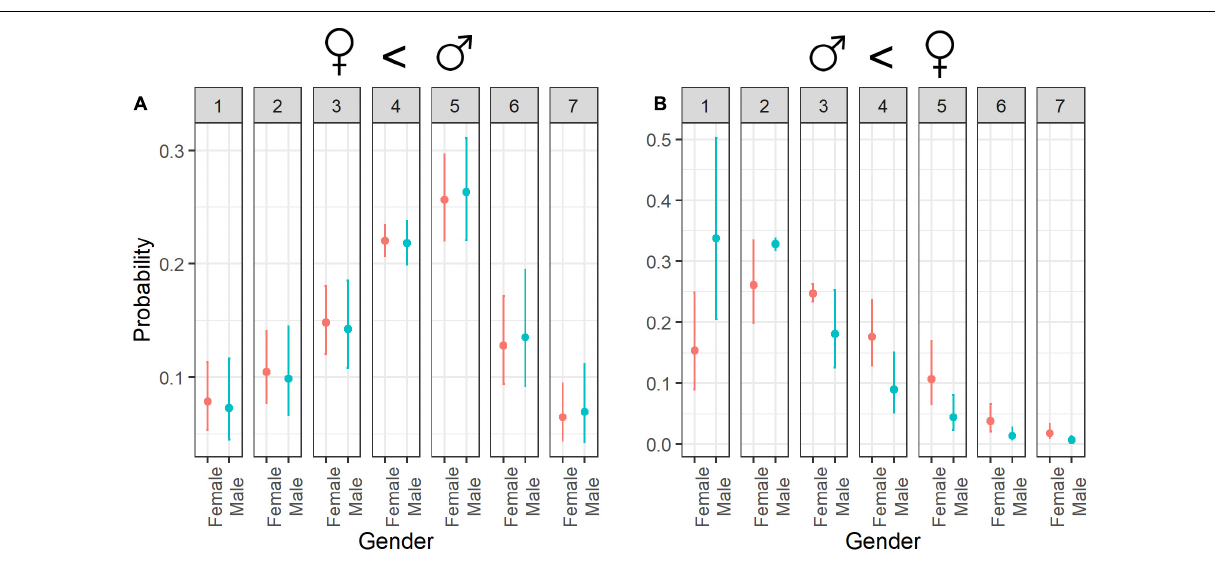
predators of our ancestors in Africa (Treves and Palmqvist,